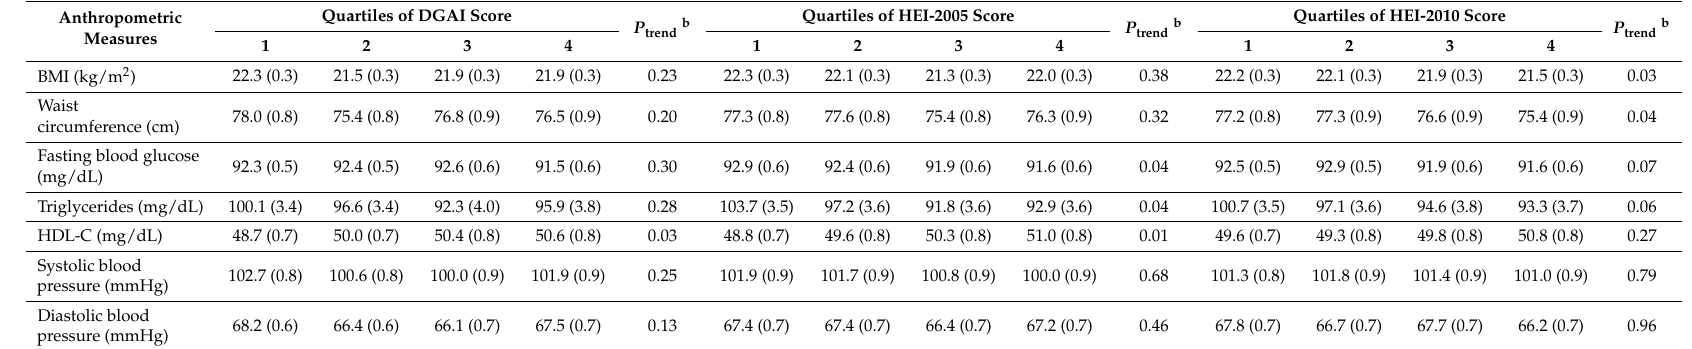
Table 5. Mean (SE) for anthropometric measures and cardio metabolic risk factors across the quartile categories of diet quality indices score in Tehran Lipid and Glucose Study adolescents a .